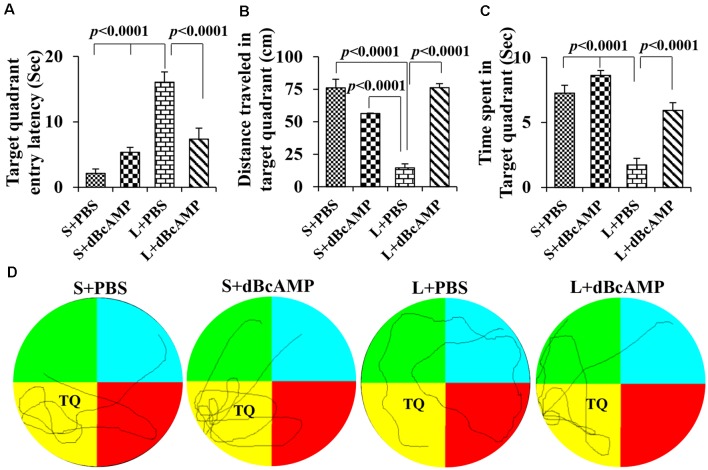
(A,B,C) Graphs showing the target quadrant entry latency (A), distance traveled in the target (platform quadrant, B), and time spent in the target quadrant (C) during the probe test. Note that the target quadrant entry latency was significantly higher in the L+PBS group compared to the S+PBS (P < 0.0001) and S+dBcAMP (P < 0.0001) groups, and it was decreased significantly in the L+dBcAMP group (P < 0.0001). The distance traveled and the time spent in the target quadrant were significantly lower in the L+PBS group compared to those of all other groups (P < 0.0001). Two-way ANOVA, Bonferroni’s test, n = 12 in all groups. (D) Video tracking of mice in the different groups during the probe test (memory retention test) 24 h after the last learning session. The platform was removed from the target/platform quadrant (TQ), where a circular platform was submerged 1 cm below the water level during the learning sessions. Note that S+PBS, S+dBcAMP, and L+dBcAMP mice entered the target quadrant quickly and kept exploring there for the platform. However, mice in L+PBS failed to reach the target quadrant and hence explored the whole maze, suggesting memory impairment.